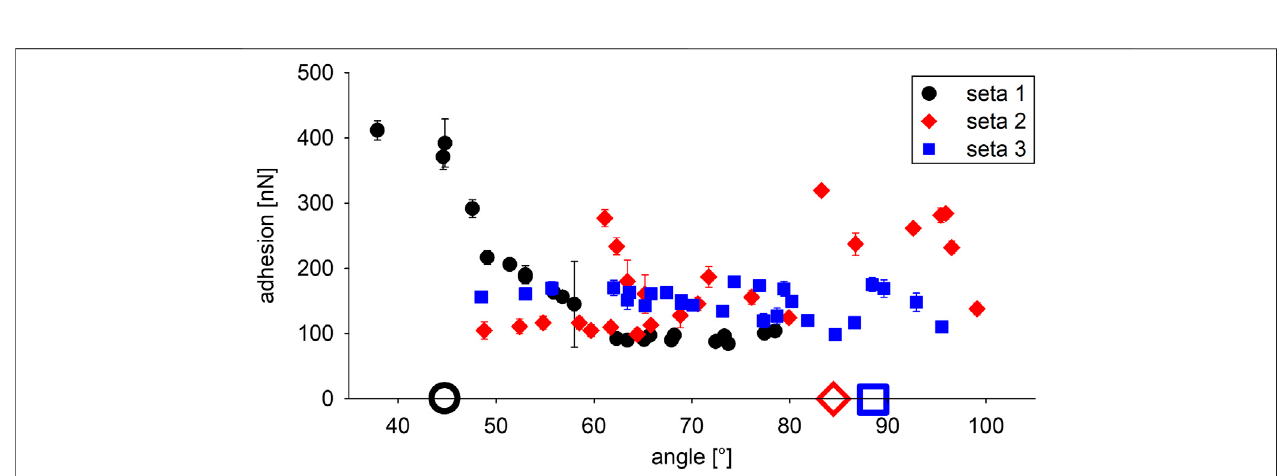
FIGURE4| Adhesionofthethreedifferentattachmentsetaeatdifferentangleswiththeglasssubstrate.Thefullsymbolsshowmeanvalues ± standarddeviationof 12measurementseach.Thelargeopensymbolsonthe x -axisindicatetheanglesoftheindividualsetaeshownin Figures3D – F chosenforthefurthermeasurementson different